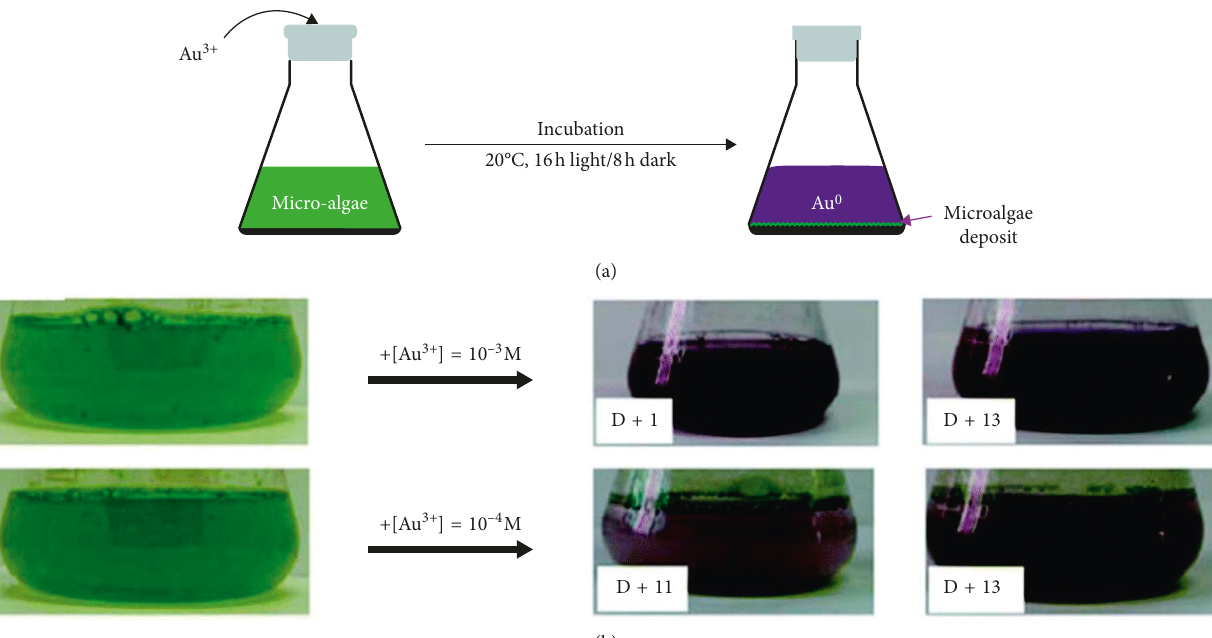
Figure 5: Algae-mediated biosynthesis of nanoparticles